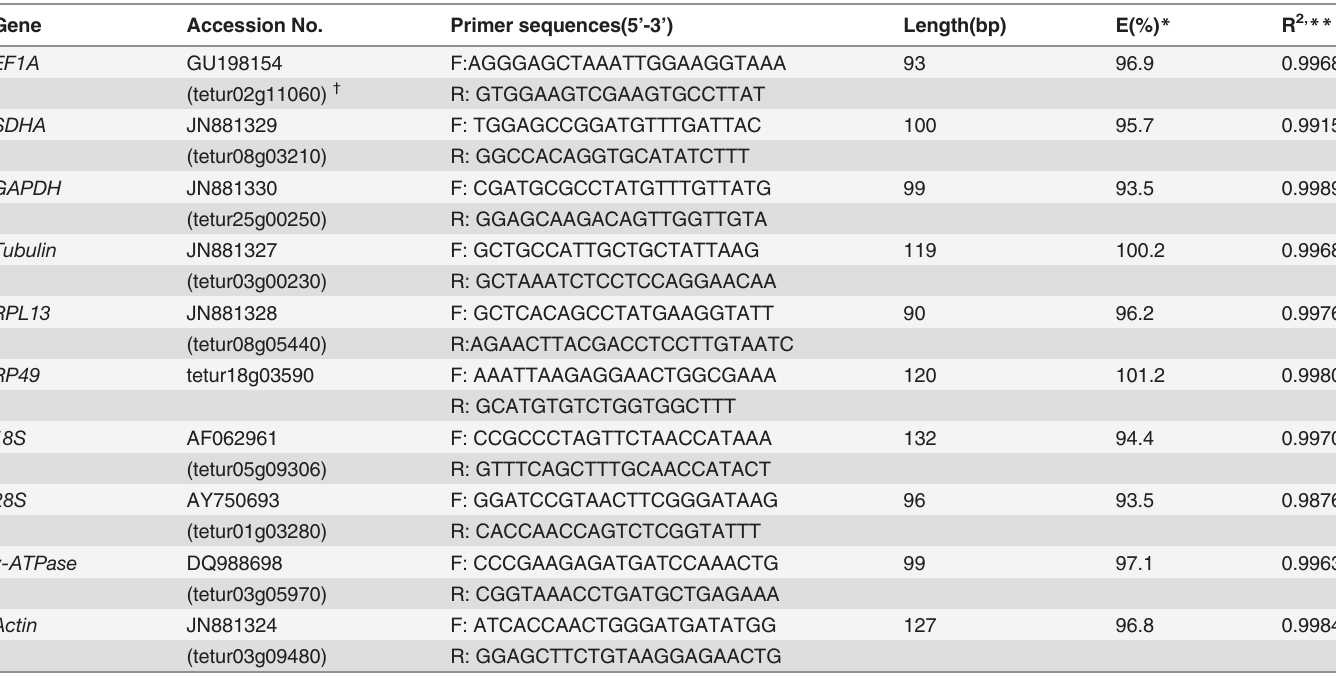
Table 1. Primer set for qRT-PCR analysis. Gene Accession